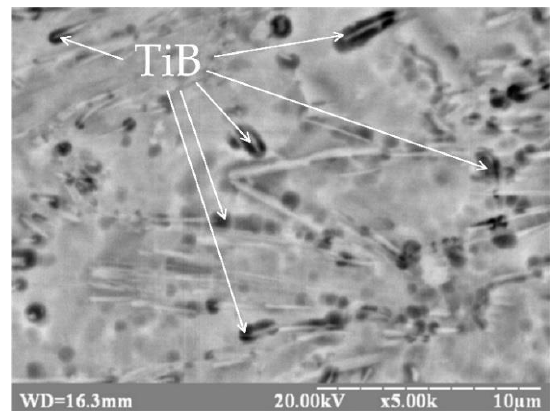
Figure 5. Distribution of boron-containing fibers in weld metal. The main characteristics of the material revealed in the welded seam area, can conditionally divide the area into three zones (see Table 3). Table 3. Characteristics of Ti-TiB n structure (by results of phase X-ray structural investigations, n = 1) in the welded seam